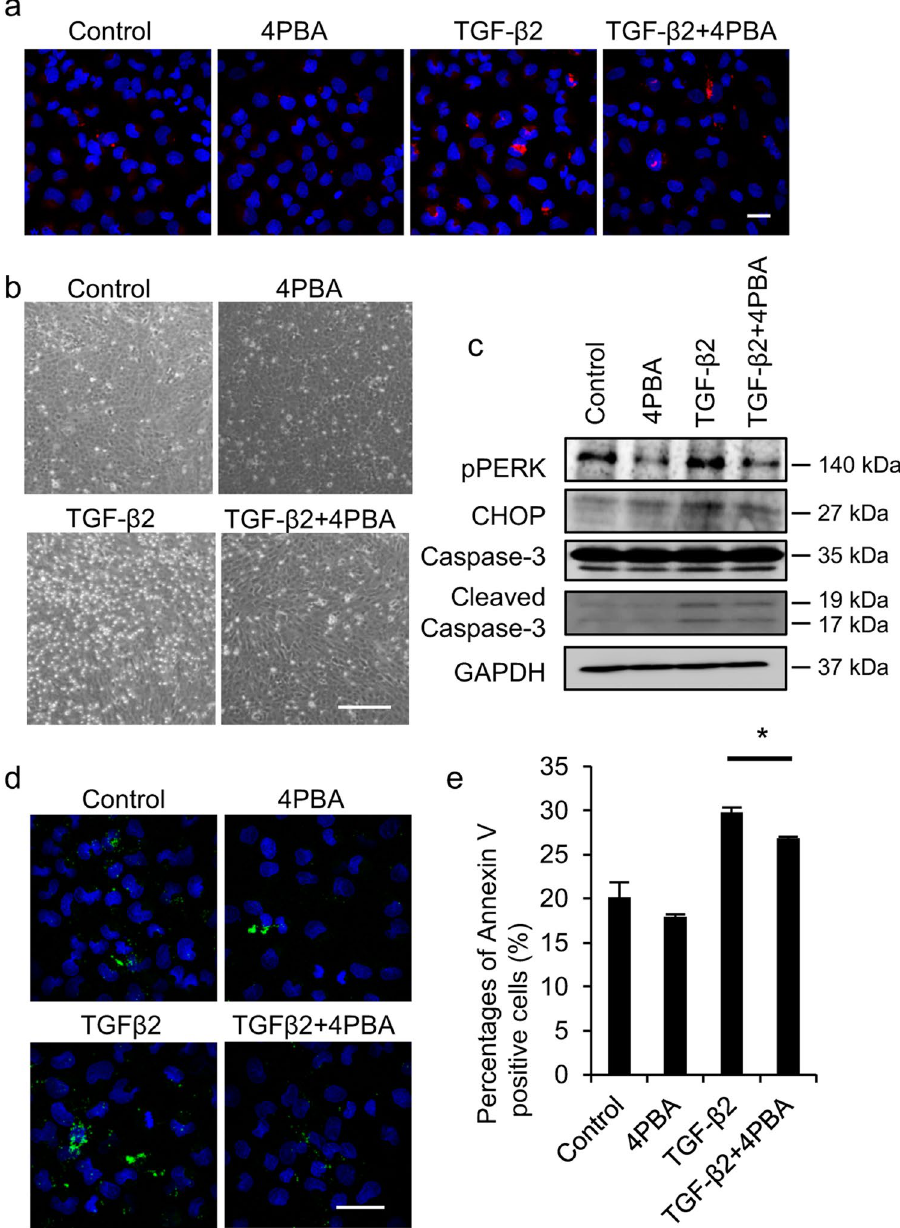
Figure 4. Effect of chemical chaperon on endoplasmic reticulum (ER) stress and intrinsic apoptotic pathway. ( a ) iFECD was treated with or without TGF- β 2 (10 ng/ml) for 24 hours, and 4 PBA (5 mM) was added to the medium to evaluate the effect of a chemical chaperone on unfolded protein formation. Unfolded protein was evaluated by aggresome staining and nuclei were stained with DAPI. Experiments were performed in triplicate. Scale bar: 50 µ m. ( b ) Representative phase contrast images are shown. TGF- β 2 induces cell detachment of iFECD, but 4 PBA suppressed the cell detachment. Experiments were performed in triplicate. Scale bar: 200 µ m. ( c ) Effect of chemical chaperon on ER stress and apoptosis was evaluated. TGF- β 2 treated samples were recovered after coincubation with 4 PBA and phosphorylation of PERK, expression of CHOP, and cleavage of caspase 3 were examined by western blotting. Full-length blot of caspase 3 is presented in Supplementary Fig. 1. GAPDH was used as internal control. Experiments were performed in triplicate. ( d , e ) Apoptotic cell were evaluated by Annexin V staining and evaluated by fluorescent microscope and flow cytometry. Nuclei were stained with DAPI for fluorescence microscopy analysis. Experiments were performed in triplicate. Scale bar: 50 µ m. The statistical analysis was performed by Student’s t-test. * P <